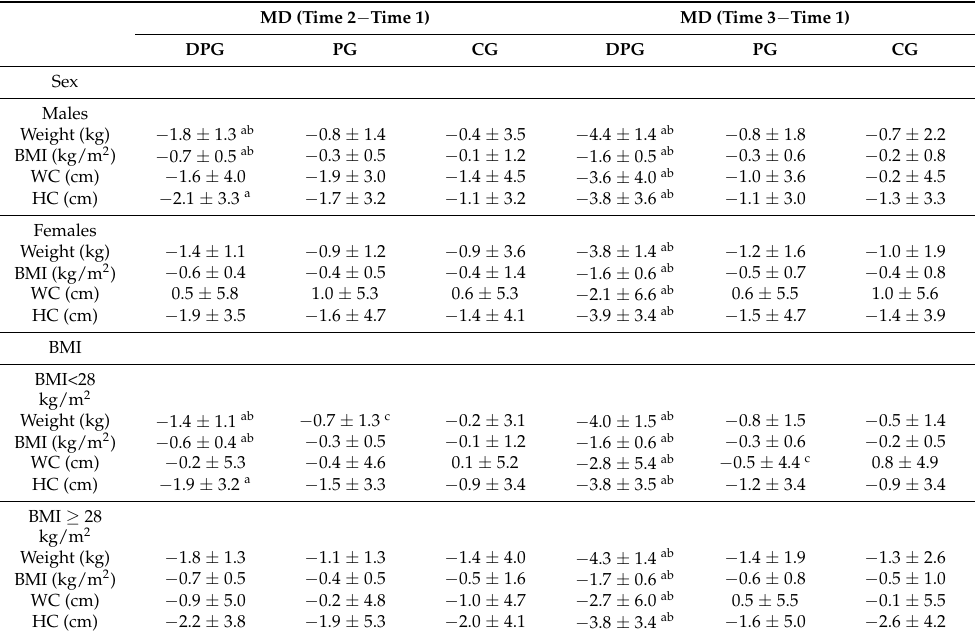
Table 4. Changes in weight outcomes at Time 1 and Time 2 compared to baseline by sex and according to BMI at baseline ( n =